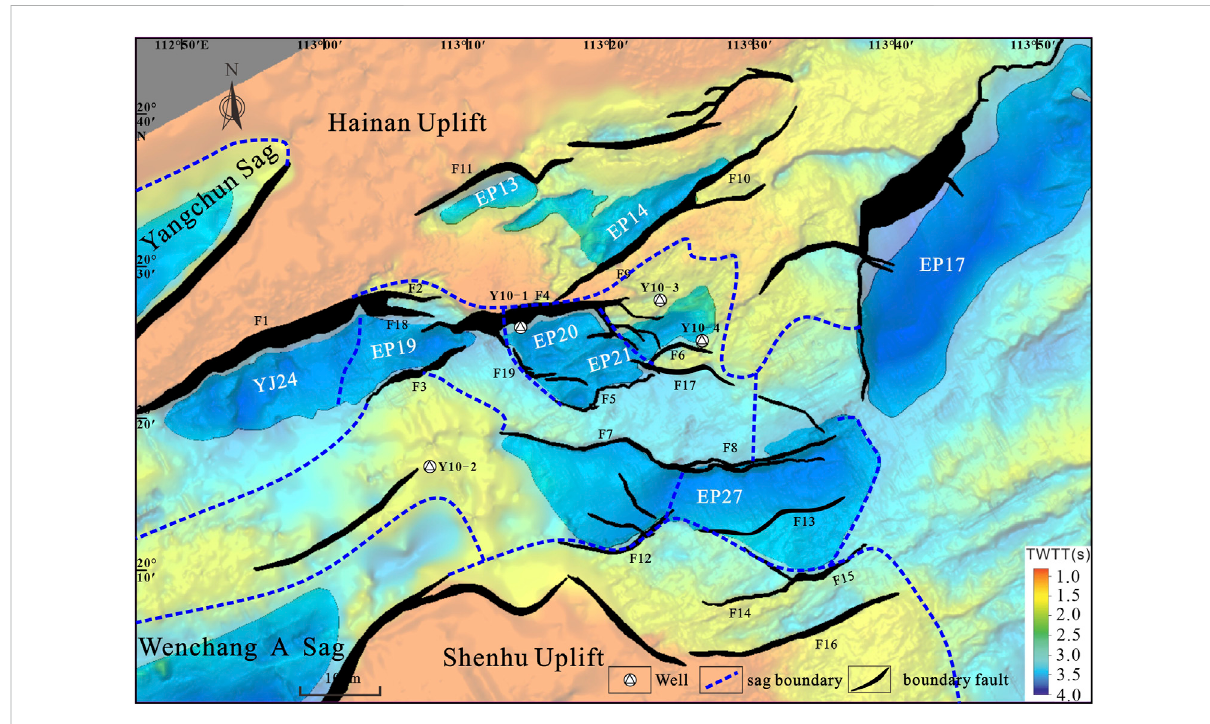
FIGURE 4 Secondary tectonic units of the Yangjiang Sag and adjacent areas (See Figure 2 for the